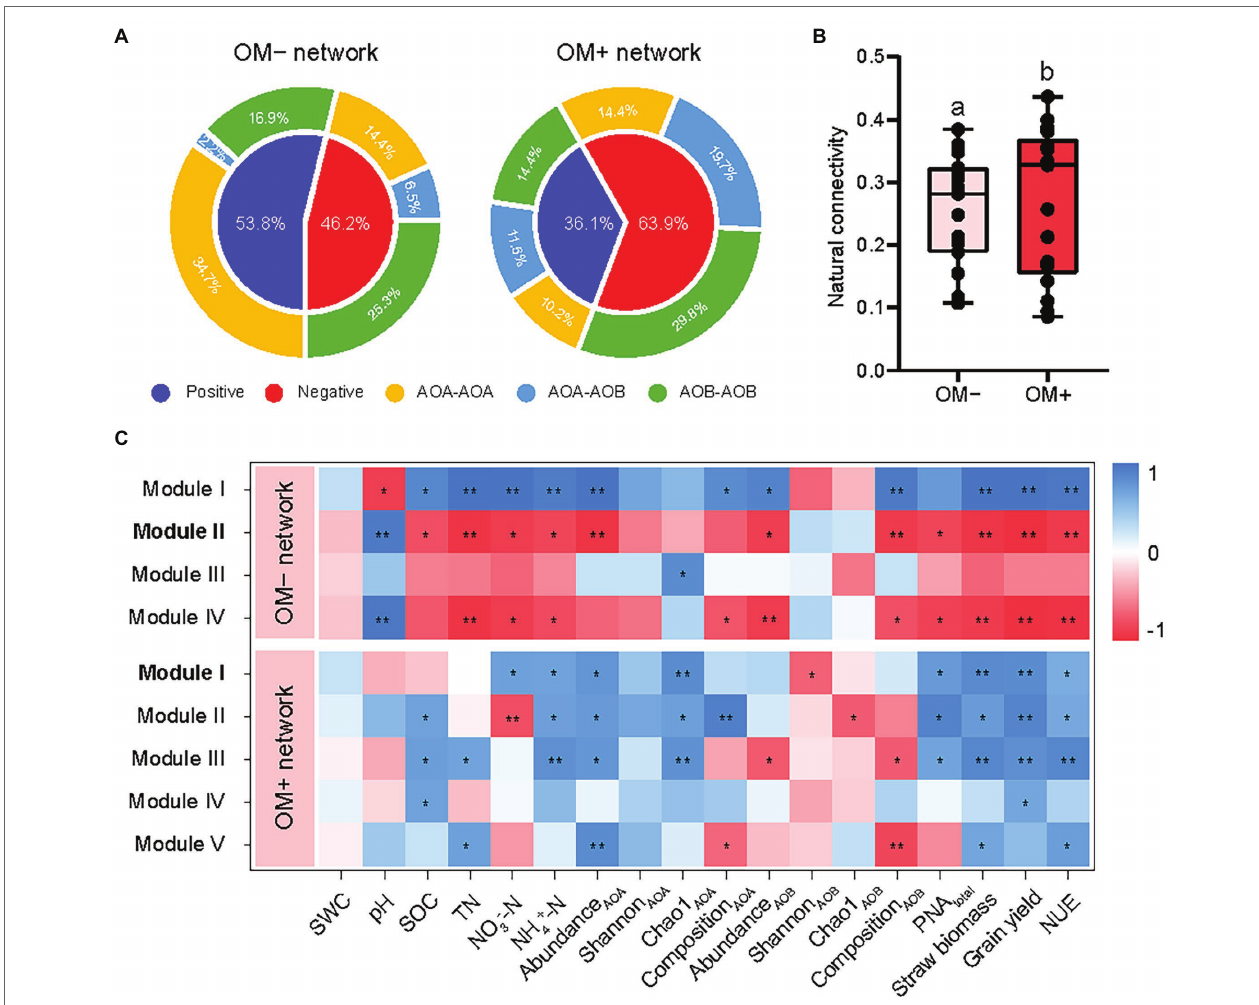
FIGURE 5 | Values of correlation types (A) between edges in the networks without (OM − ) and with (OM+) organic material amendments. The co-occurrence network robustness (B) in OM − and OM+ is indicated by the natural connectivity. Correlation coefficients (C) between module eigengenes, soil properties, AOA and AOB populations, PNA total , plant productivity (grain yield and straw biomass), and nitrogen use efficiency (NUE). Different lowercase letters indicate significant differences based on Tukey’s HSD test ( p < 0.05). The modules with keystone taxa in the OM − and OM+ networks are in bold. SWC, soil water content; SOC, soil organic carbon; TN, total nitrogen; NO 3 − -N, nitrate nitrogen; NH 4+ -N, ammonia nitrogen; PNA total , the sum of potential nitrification activity of AOA and AOB. ** p < 0.01; * p <